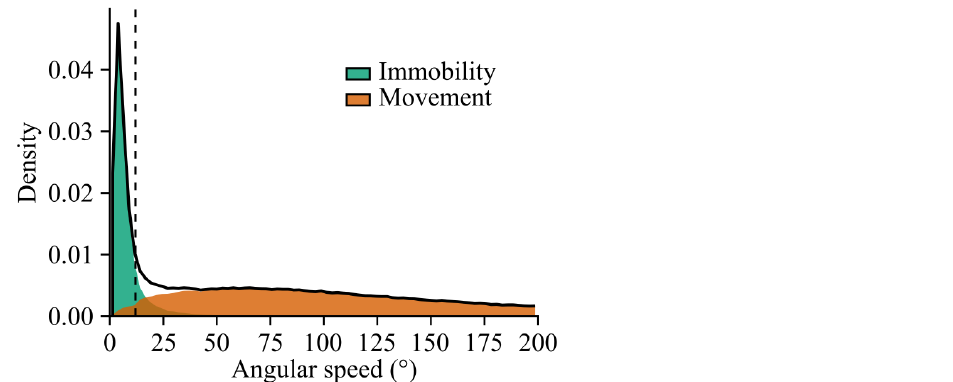
Figure A3. The distribution of angular speed values (i.e., the norm of the angular velocity vector) for one example recording is shown (solid black line) on top of the distributions obtained after applying a threshold of 12°s − 1 (dashed line), merging sub-threshold intervals close in time and discarding very brief sub-threshold periods (see Section 2.9). The threshold was positioned to separate the two modes of the original